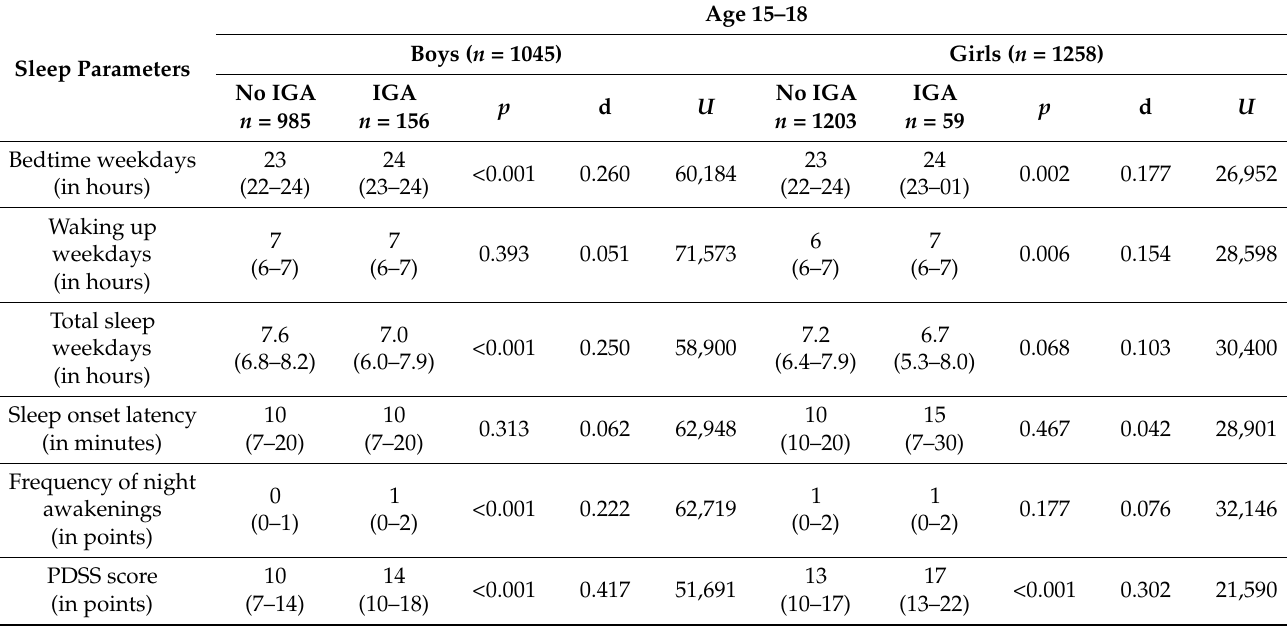
Table 6. Sleep parameters in adolescents aged 15–18 with Internet game addiction (IGA) verified with Game Addiction Scale for Adolescents (GASA).